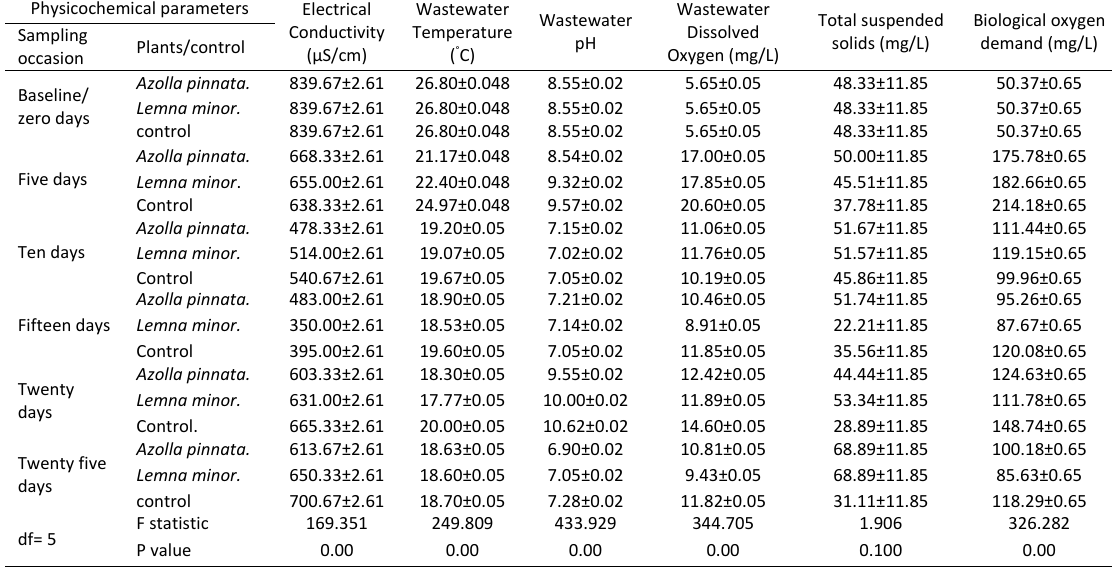
Table 2: Showing physicochemical parameters (means ±SE) of the wastewater in different sampling occasions Physicochemical